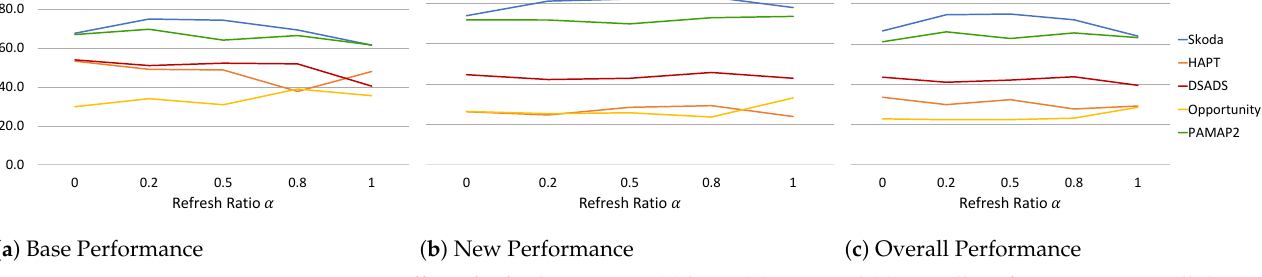
Figure 6. Effect of refresh ratio α on ( a ) base, ( b ) new, and ( c ) overall performance across all